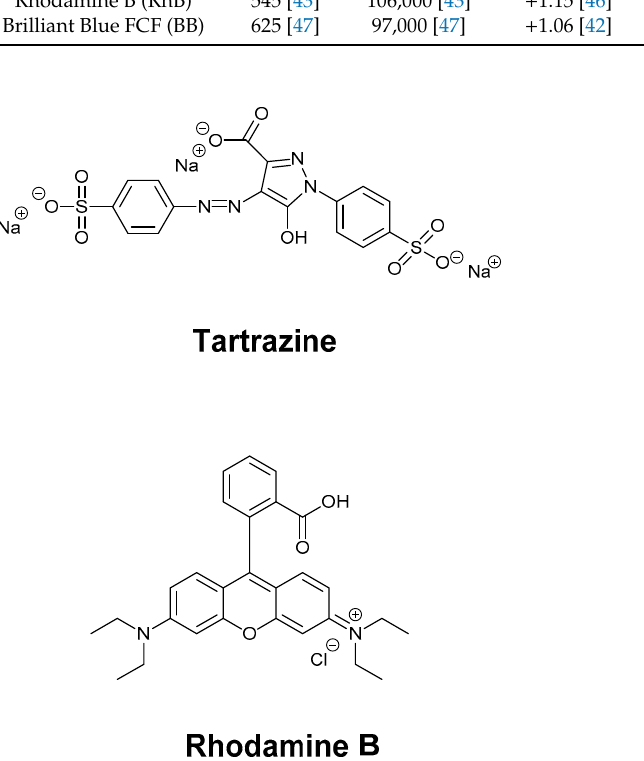
Figure 1. Chemical structures of the selected synthetic dyes.